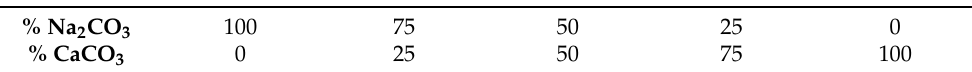
Table 1. The catalyst mixtures for dual catalyst resorcinol–formaldehyde xerogels produced in this